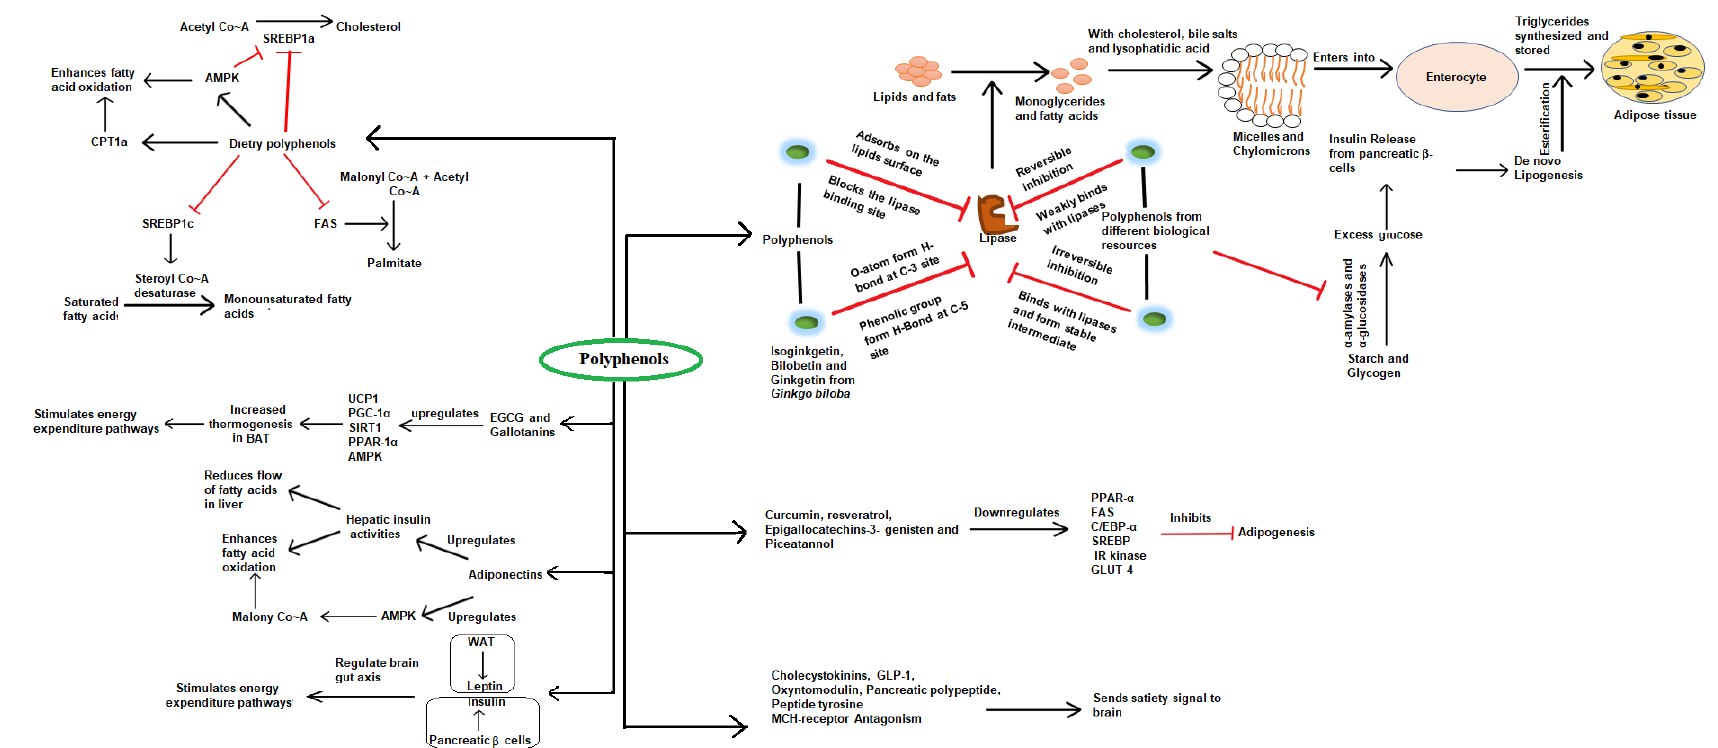
Figure 3. Diagram showing the different steps mainly regulated by polyphenols in managing obesity.